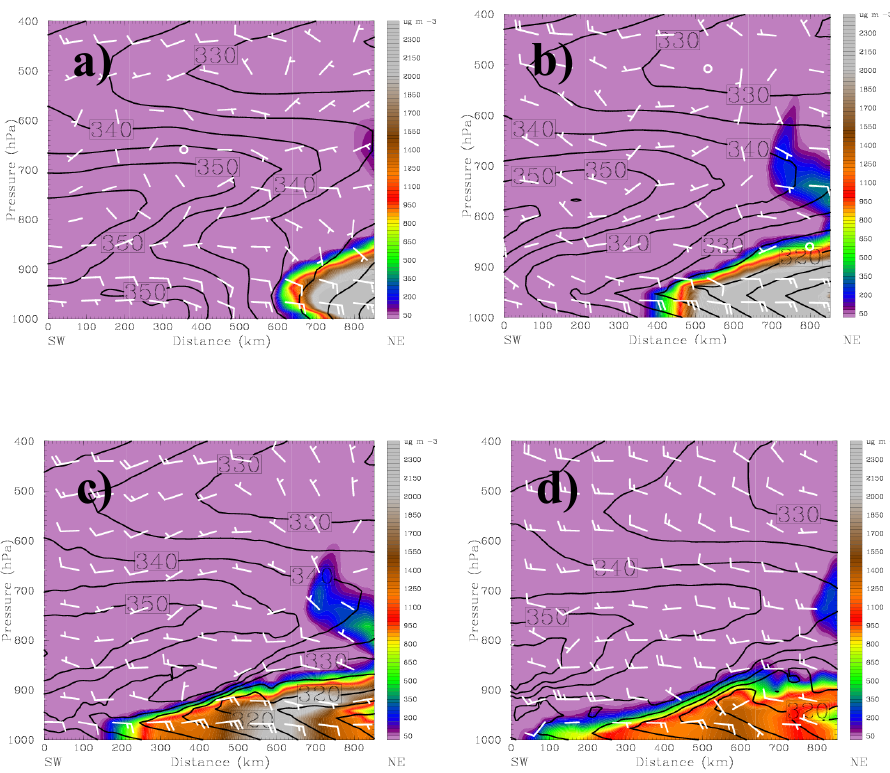
Fig. 10. The cross-section distribution of wind field, theta-e (contour) and PM 10 concentration (colored) along NE1 in Fig. 9 at (a) 18:00UTC, 20 March (b) 00:00UTC, 21 March (c) 06:00UTC, 21 March (d) 12:00UTC, 21 March. A full (half) wind barb indicates 5ms − 1 (2.5ms − 1